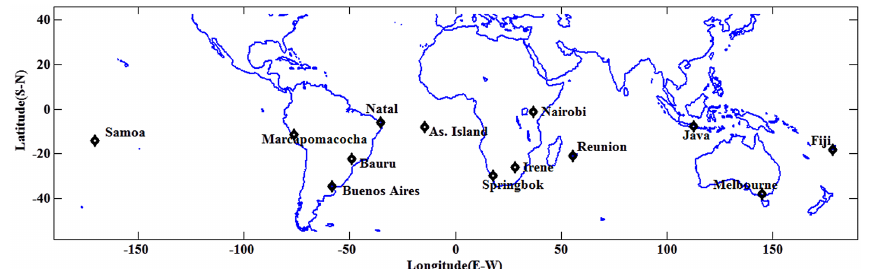
Figure 1. Geolocations of the 13 stations in the Southern Hemisphere selected for this